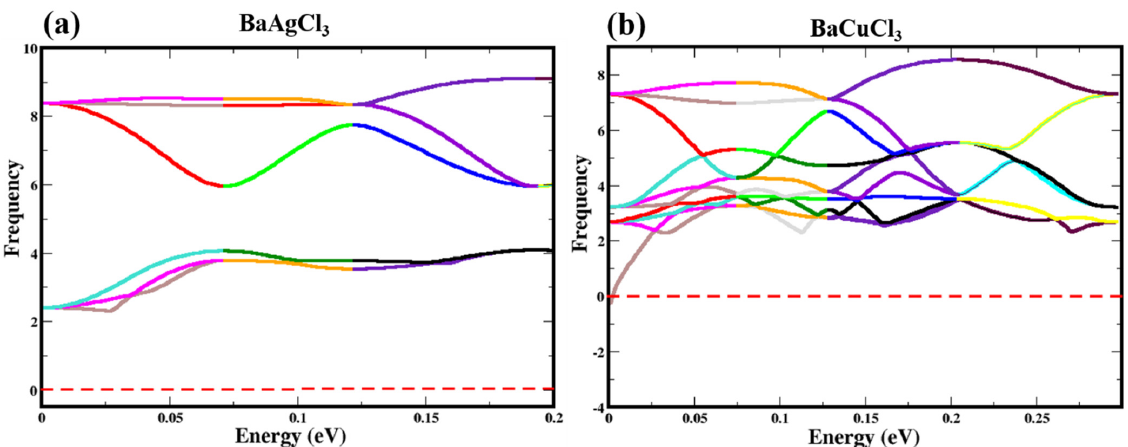
Figure 3. The computed phonon dispersion bands structure of cubic ternary ( a ) BaAgCl 3 and ( b ) BaCuCl 3 chloroperovskites compounds.